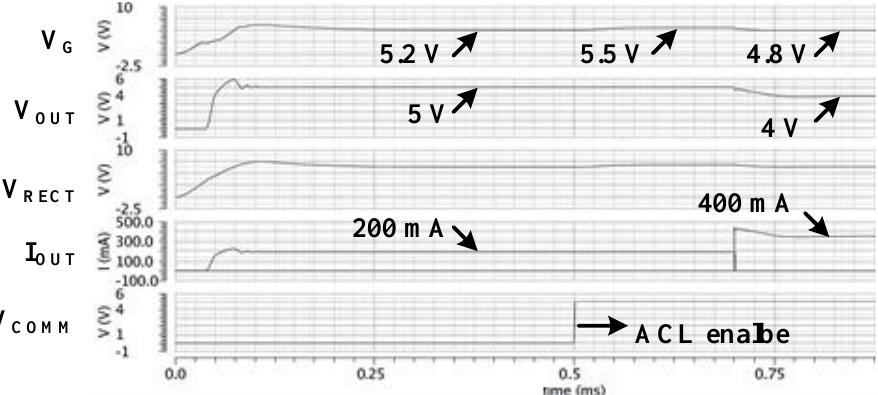
Figure 8. Simulation results of multi-feedback LDO (MF-LDO) regulator.